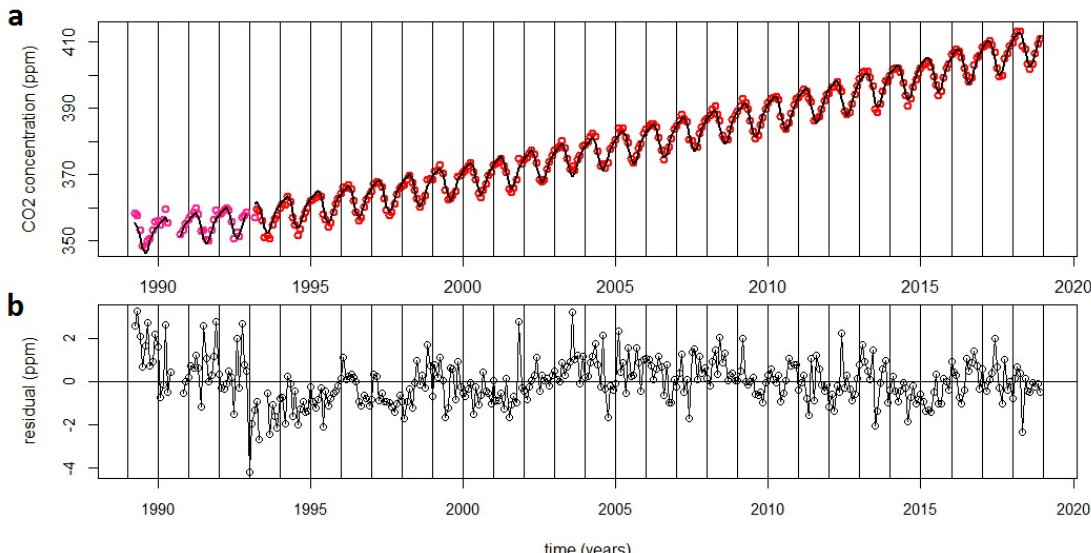
Figure 11. Monthly means at Plateau Rosa from 1989 to 1993 (pink points) and from 1993 to 2018 (red points), the exponential and periodic fitting functions (4 harmonics) (black line) ( a ), residual between the data and fitted curve ( b ).